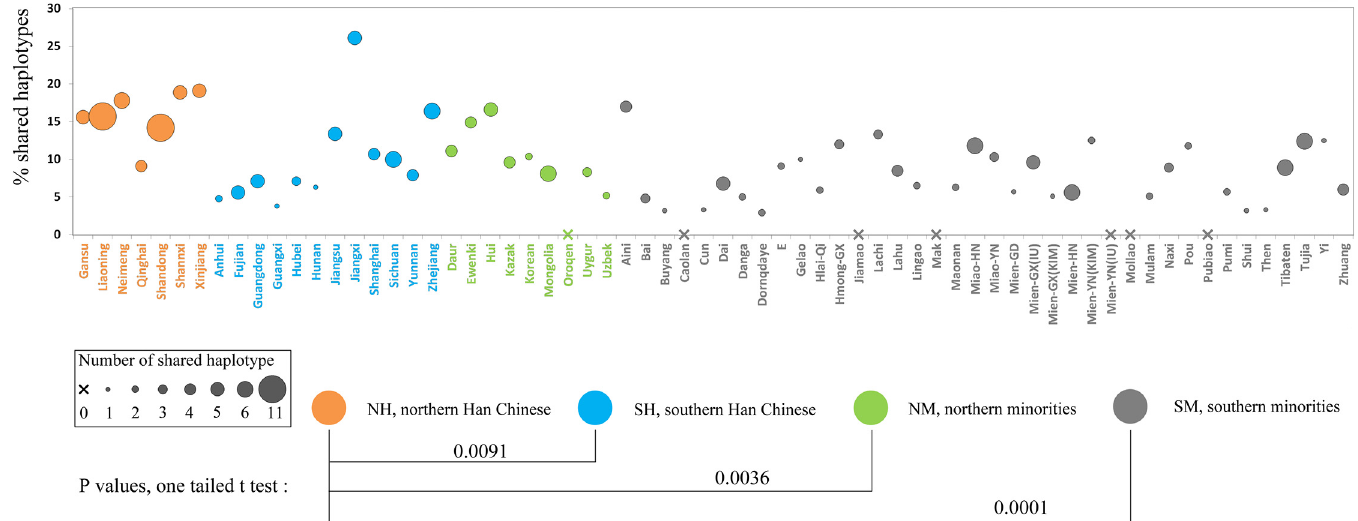
Fig 3. Percentage of haplotypes found in Hengbei individuals and matched in various present-day populations of China.